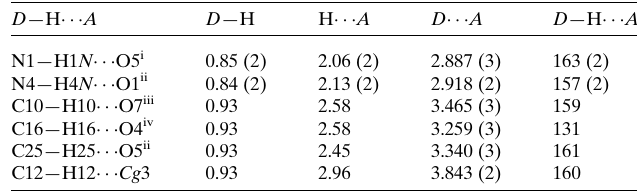
Table 3 Hydrogen-bond geometry (A˚ , (cid:3) ) for